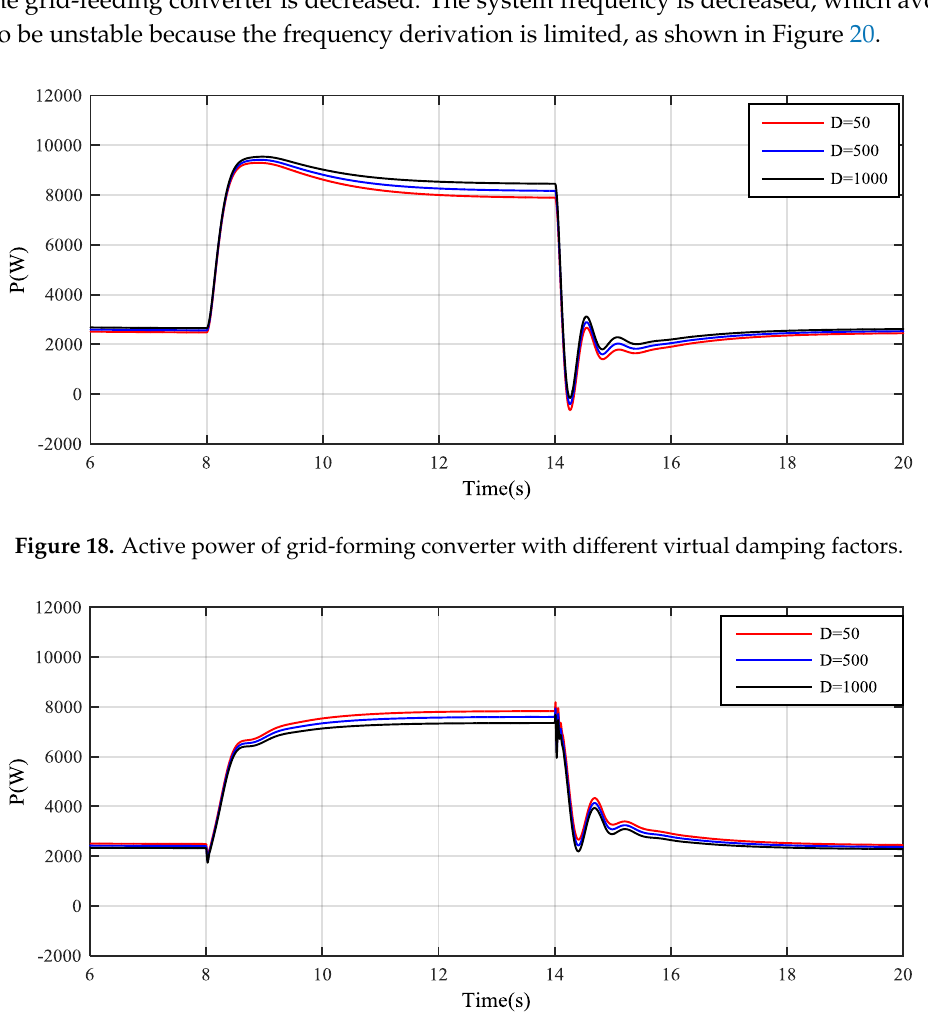
Figure 19. Active power of grid-feeding converter with different virtual damping factors.